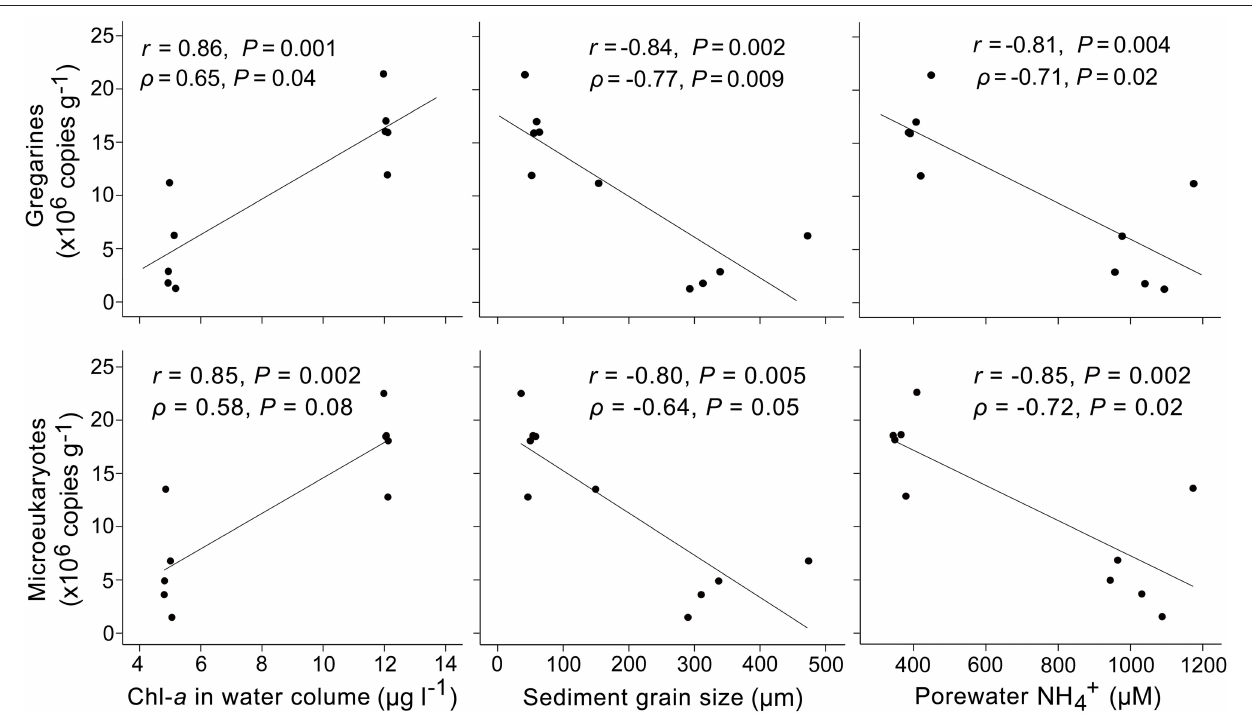
FIGURE 6 | Correlations between the 18S rRNA gene abundances of gregarine apicomplexans, all microeukaryotes, and the measured environmental factors across vegetated and unvegetated sediments. The gene copy number of gregarines was significantly and positively correlated with the concentration of chlorophyll a in the overlying water and negatively with the sediment grain size and concentration of ammonium in sediments. Note that the gene copy number of microeukaryotes was estimated based on the gregarine abundance and their read proportion in the